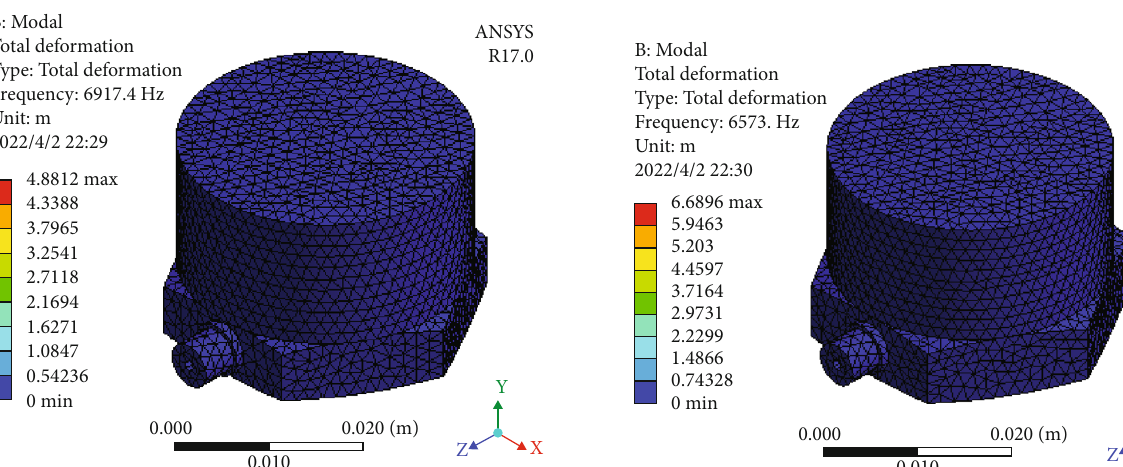
Figure 12: Voltage distribution for case 3.